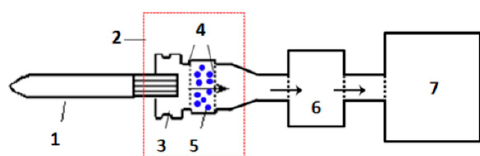
Figure 2. Device to simulate the addition of absorbents to the cigarette filter. (1) cigarette, (2) homemade device, (3) cigarette holder, (4) 120 mesh sieve, (5) sample, (6) Cambridge filter pad, and (7) smoking machine.